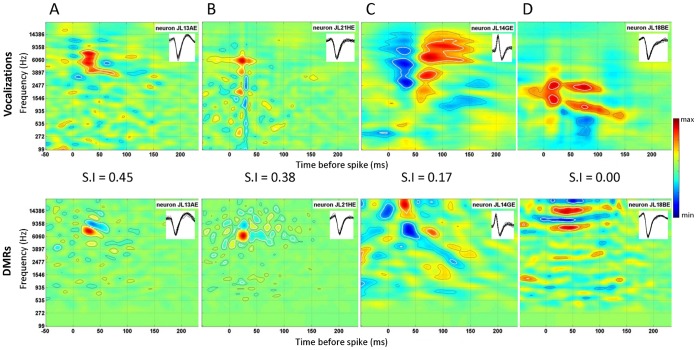
Individual examples for four neurons exhibiting either similar (A. and B.) or different (C. and D.) STRFs derived from responses to vocalizations (top row) and responses to dynamic moving ripples (DMR, bottom row).For each STRF, the color code represents “excitation” in red and “inhibition” in blue, units are in spikes/(sec2*dB). In A. and B., the neurons display relatively similar STRFs with vocalizations and DMRs: The best frequency (BF) was similar with vocalizations and DMRs (6.5 kHz in A and B) and the excitation area was circumscribed to the same frequency range, despite some differences in the overall shape. Thus, the similarity index (SI, indicated between the two rows) was relatively high (0.45 and 0.38). In C. and D. the neurons display quite different STRFs estimated from responses to vocalizations and DMRs; in particular, the BF, the shape and the frequency range of the excitatory area differed. Therefore, the values of the SI are low (0.17 and 0.00). Insets in each STRF show the AP waveform during presentation of the stimuli.